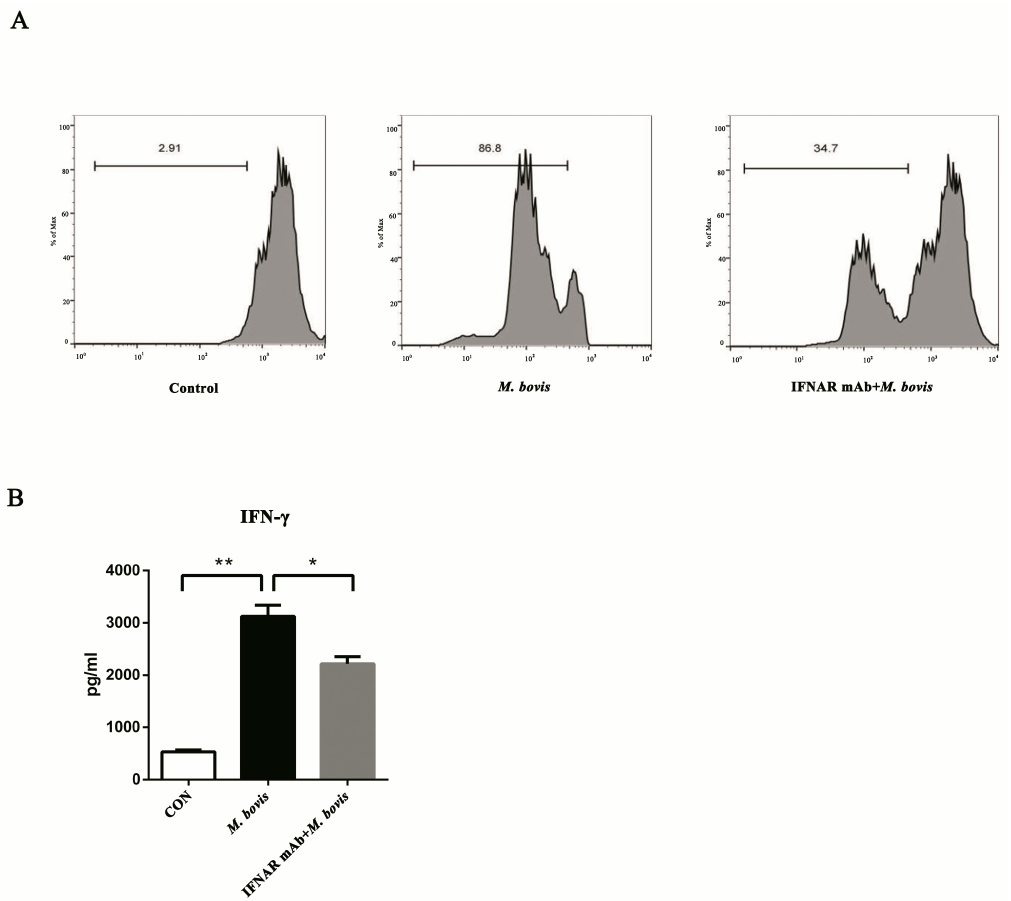
Figure 4. BMDCs promote T cell activity in the presence of type I interferons. ( A ) The proliferation of CD4 + T cells was analyzed by flow cytometry after 72 h co-culture. The interferon receptor was treated with neutralizing anti-mouse IFNAR mAb (10 ng/mL) to block and then infected for 24 h with M. bovis (MOI 5). CFSE-stained CD4 + T cells were co-cultured with three different BMDC groups, and the ratios of BMDC:T cells were 1:10 for 72 h. ( B ) After 72 h co-culture, the culture supernatants were harvested and assessed by ELISA. All data are expressed as mean ± SD. The number above the horizontal bar represents the proliferation rate of CD4 + T cell, (* p < 0.05; ** p < 0.01; n.s.: no statistical significance).